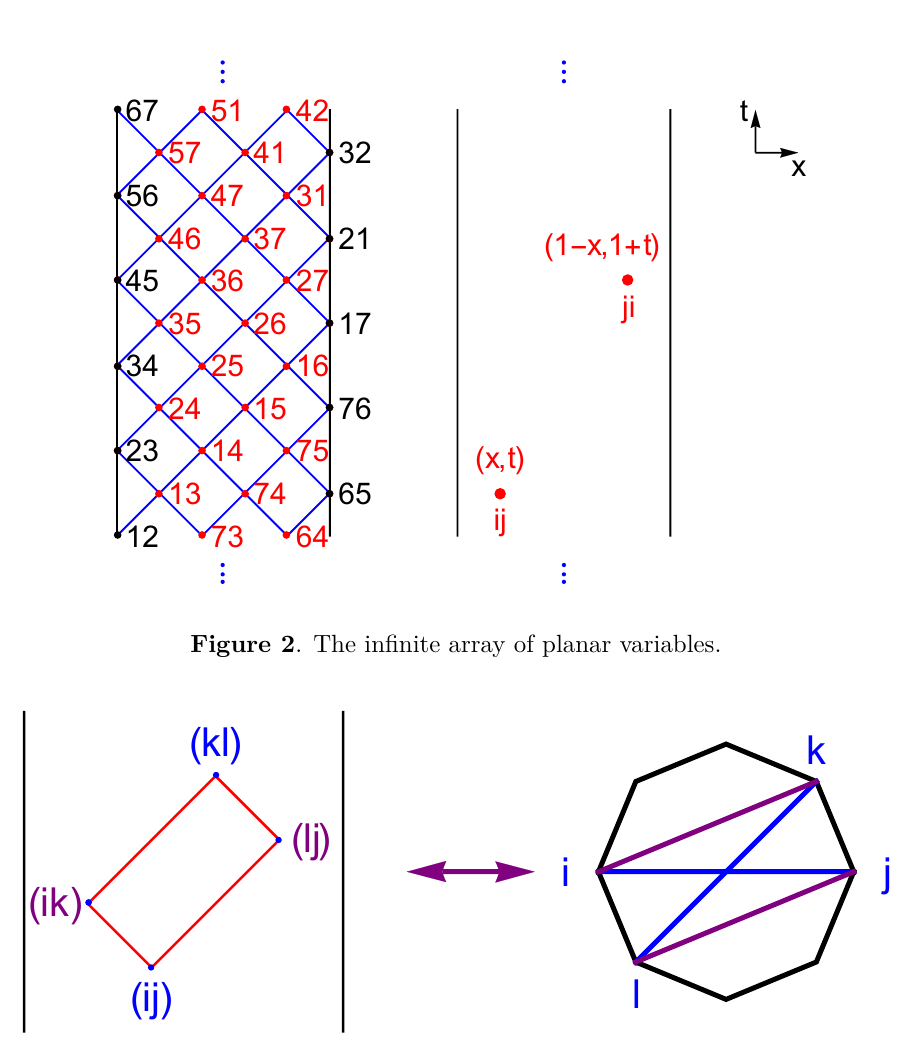
Figure 3 . Diagonals on an n-gon and the corresponding points in the (1 + 1) -dimensional space-